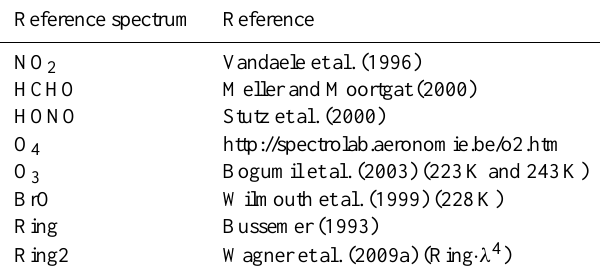
Table 1. Cross sections used in the DOAS